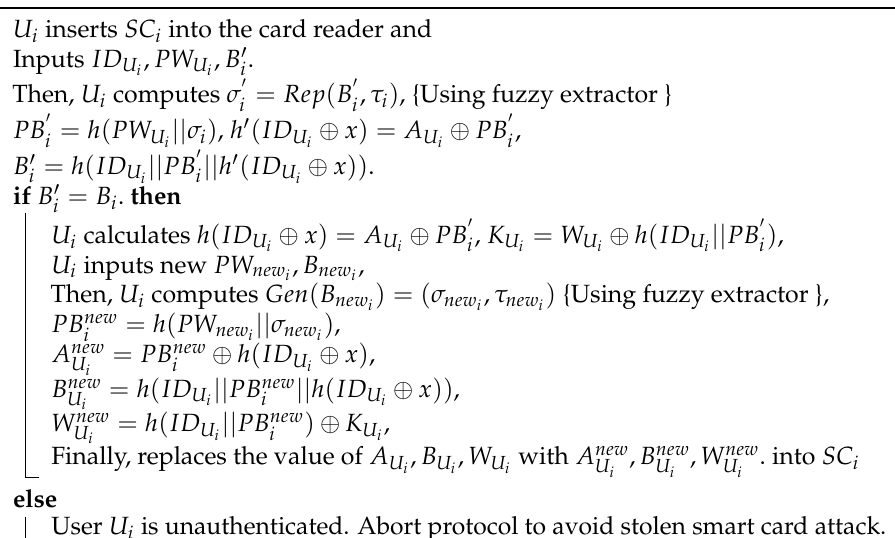
Table 9. User’s credential update phase of proposed